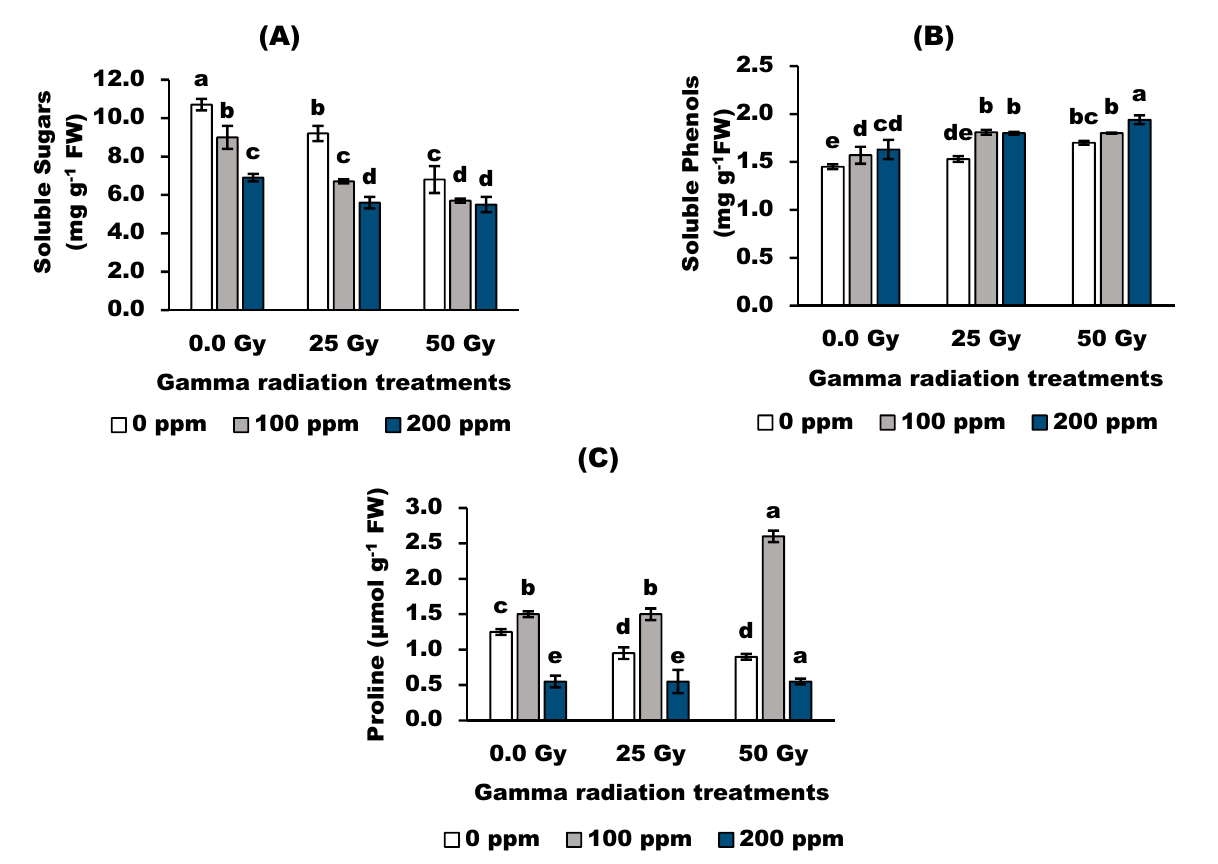
Figure 3. Effect of stigmasterol treatments on compatible solutes; ( A ) soluble sugars, ( B ) soluble phenols, and ( C ) proline of wheat plants grown from grain irradiated with gamma rays. The different letters (a–e) show statistical significance at p < 0.05; vertical bars indicate ±SD.